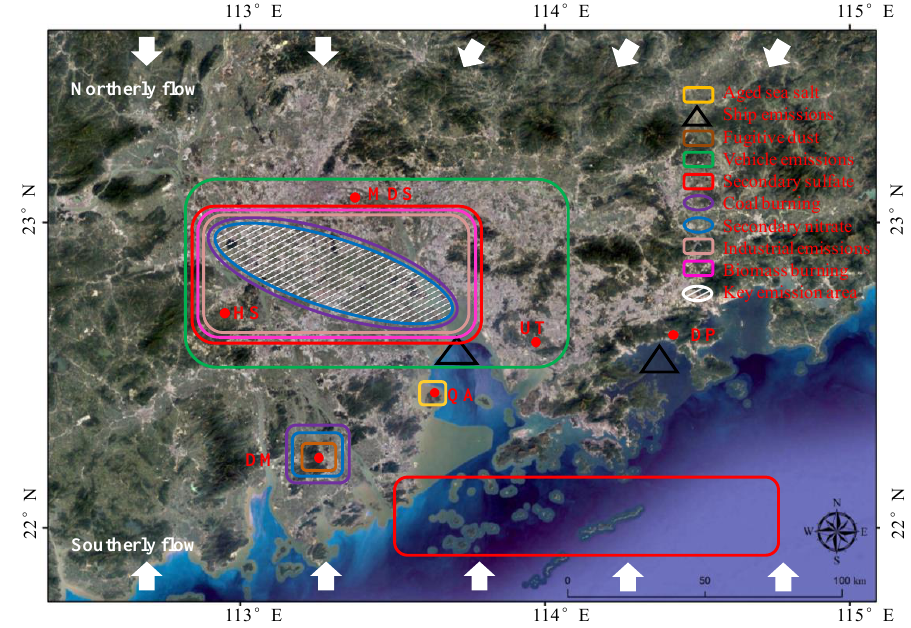
Figure 9. The schematic diagram of high-emission areas in the PRD (map from Google Earth). The white shaded area indicates the key emission area for the multiple sources of SO 2 , NO x , coal burning, biomass burning, industrial emissions and vehicle emissions and is explained further in the